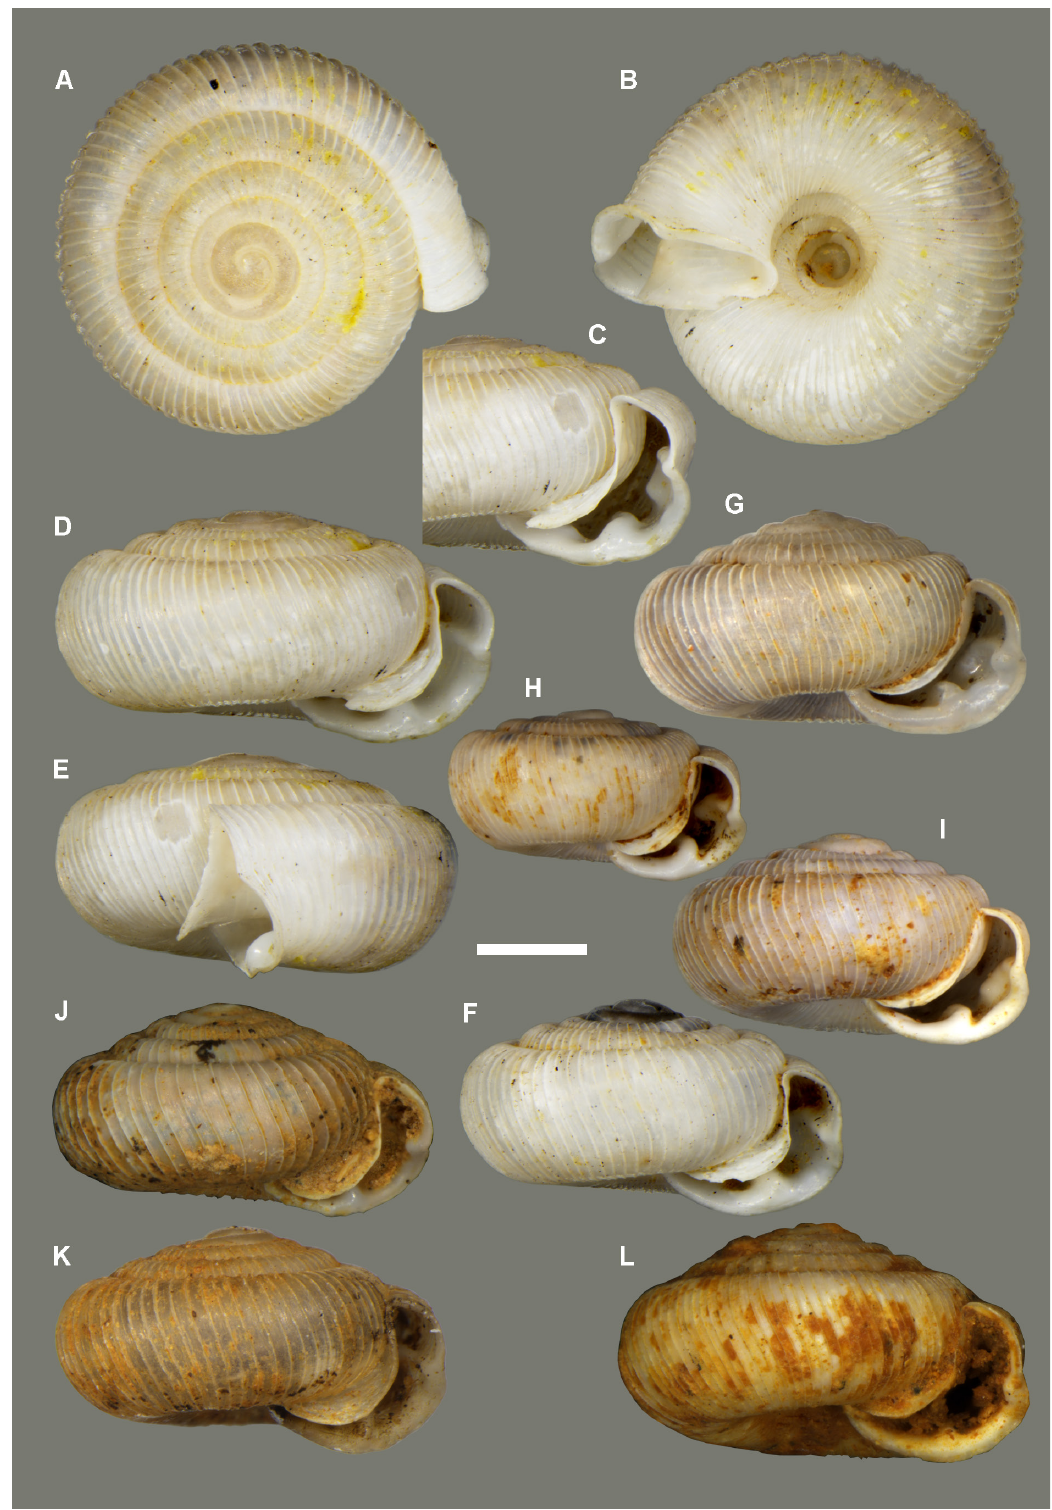
Fig. 6. Shells of Virpazaria (Aemiliella) ripkeni Gittenberger, 1969. A–E . Holotype (NHMW 77153). F . Paratype (NHMW 77153a). G . Malkolaj (HNHM 103437). H–I . Gadoc (HNHM 103429). J . Drisht (HNHM 104392). K . Holotype of V. pastorpueri Reischütz et al. , 2011 (NHMW 107855). L . Kruni i Baksit (HNHM 103433). Scale bar = 1